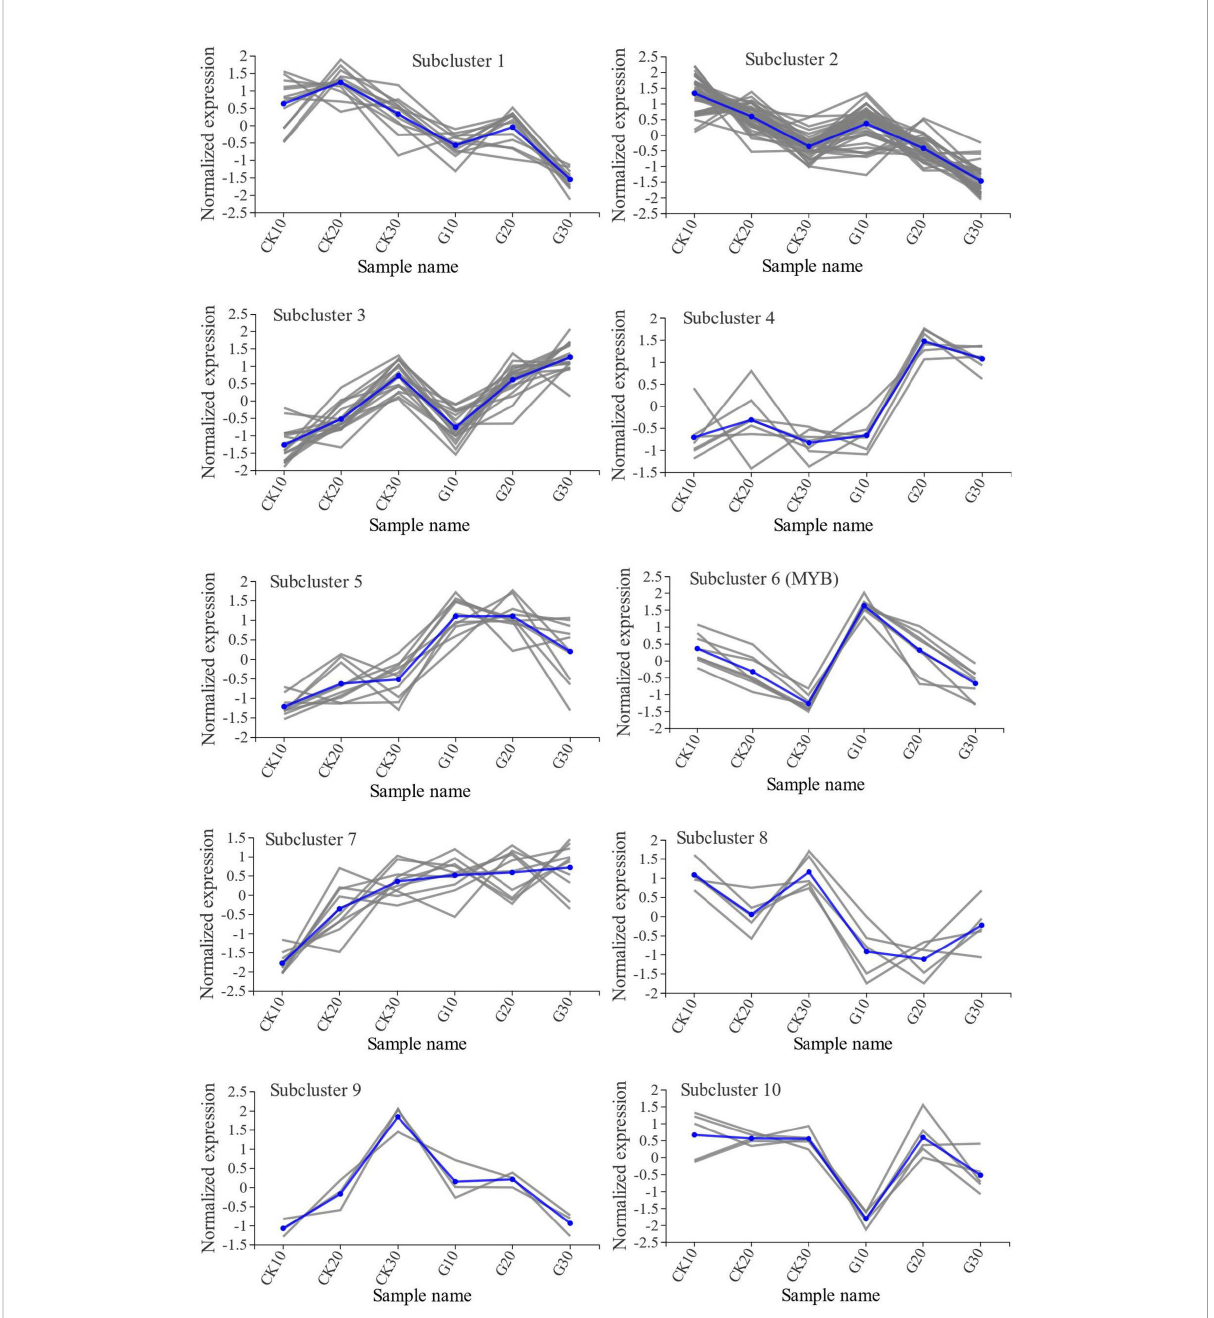
FIGURE 8 Cluster analysis of DEGs encoding transcription factors. DEGs were classi fi ed into 10 subclusters by K-means cluster analysis. Blue lines represent the average trends of all gene expressions within